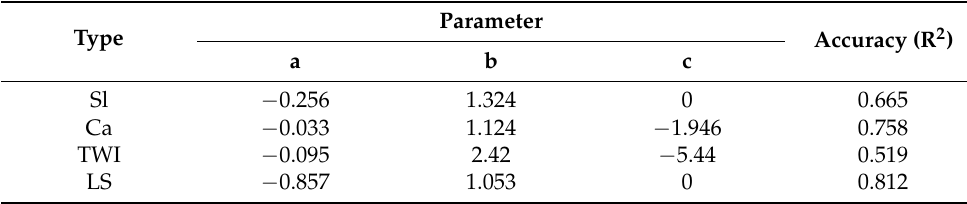
Table 3. Single factor parameters based on power function fitting.